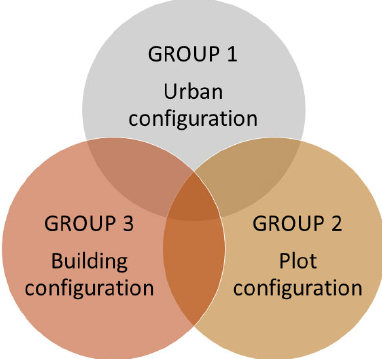
Figure 6. Scheme of interrelationship between the study groups (GR1, GR2, GR3). Own elaboration.